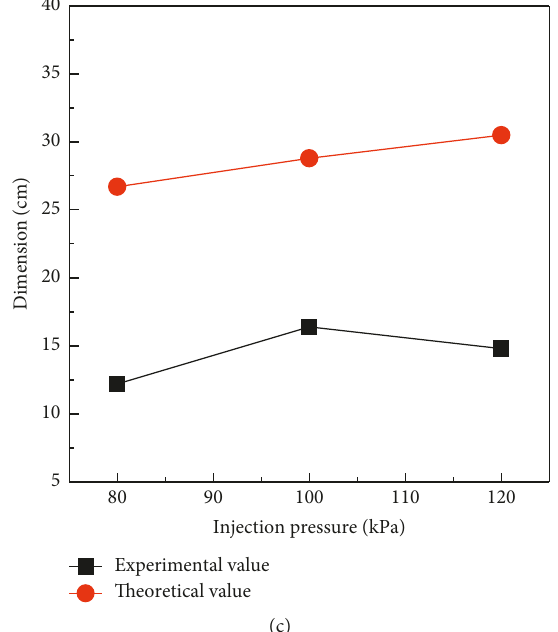
Figure 10: The vertical dimension of grout concretion under different ( w / c ) ratios. ( w / c ) ratios of (a) 1.0, (b) 1.5, and (c) 2.0.